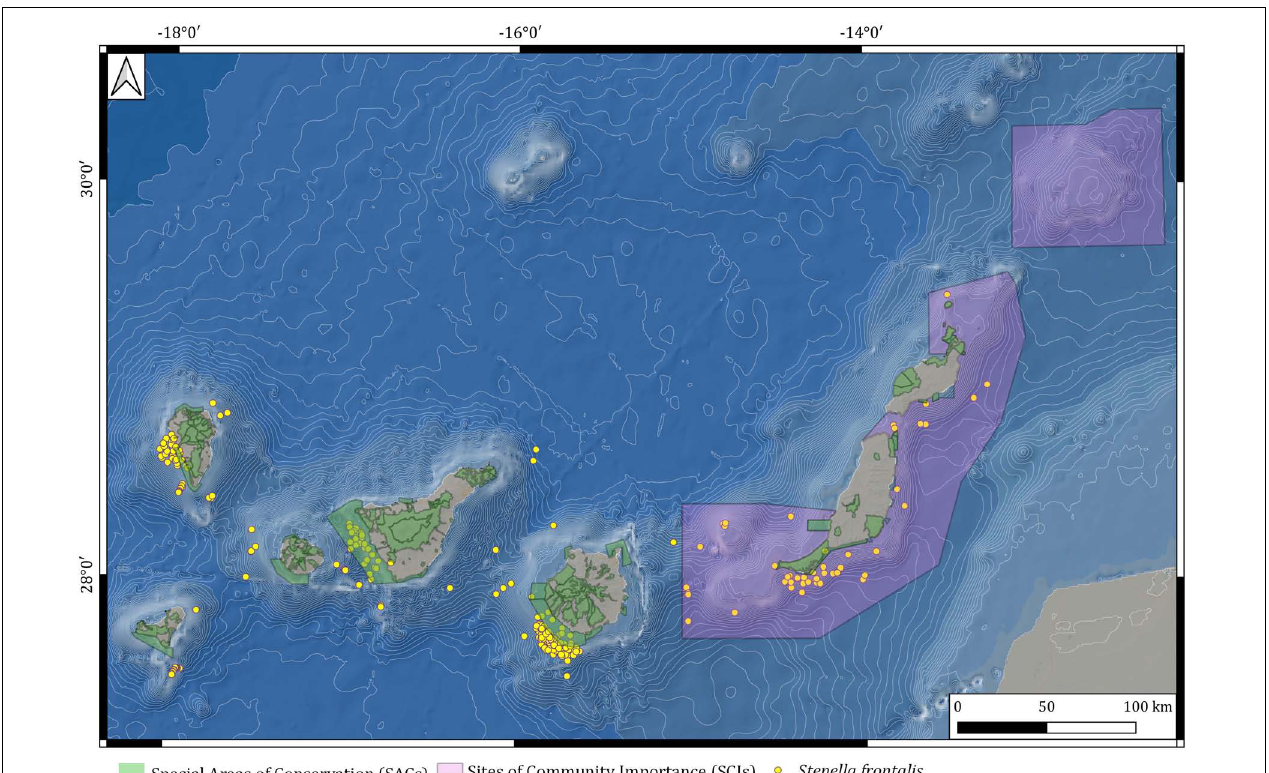
FIGURE 9 | Stenella frontalis spatial distribution around the Canary archipelago (yellow circles), including the Special Areas of Conservation (SACs; green color) and the Sites of Community Importance (SCIs; pink